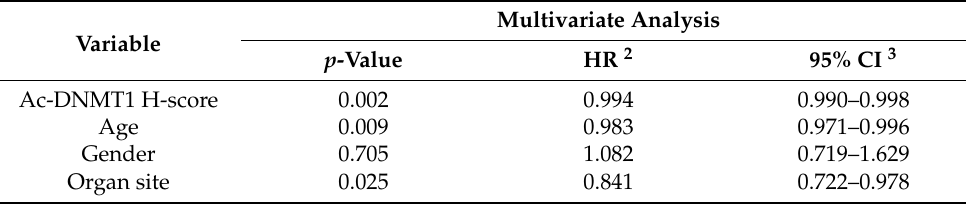
Table 1. Multivariate analyses including ac-DNMT1 protein levels for 4-year MSS 1 in stage IV melanoma